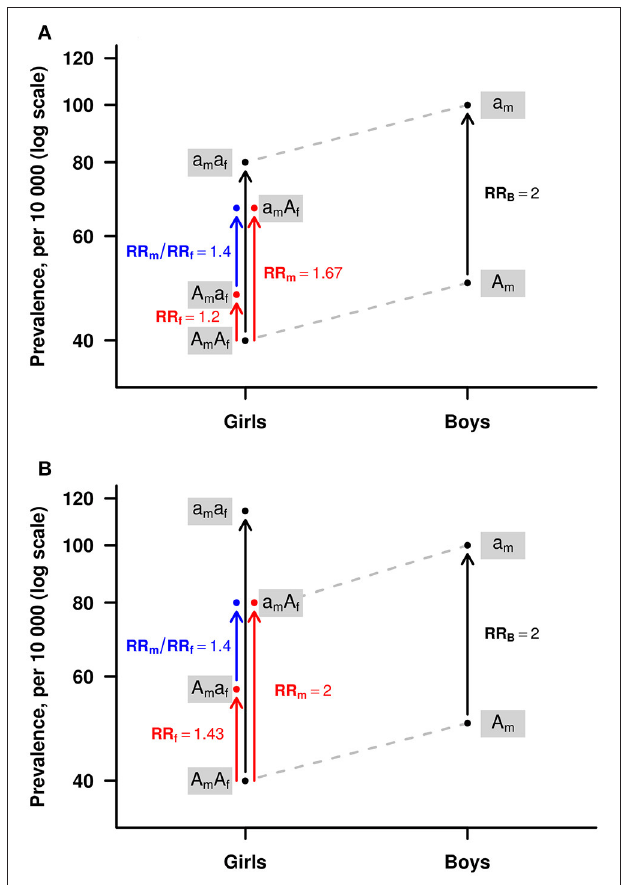
FIGURE 1 | An illustration of the Haplin model for parent-of-origin (PoO) effects on the X chromosome. The red arrows show the relative risks associated with girls inheriting the risk allele “a” from the mother (RR m ) or from the father (RR f ). Under the multiplicative risk model illustrated here, the relative risk increase for “aa” girls, i.e., girls inheriting allele “a” from both the mother and the father, is RRaa = RR m *RR f . The ratio RR m /RR f = 1.4 is a measure of the PoO effect (blue arrow). The risk increase for boys when inheriting the “a” allele is RR B = 2.0. Under the assumption of X-inactivation (A) , the risk increase for girls inheriting “aa” is the same as that for a single “a” in boys, i.e., RRaa = RR B . Under the assumption of no X-inactivation (B) , the risk increase for girls inheriting “a” from the mother is the same as that for boys, i.e., RR m = RR B . In the model without X-inactivation, when a girl inherits “a” from the father as well, this may lead to a higher total risk increase for girls than for boys inheriting the one “a” from the mother. In this illustration, RRaa = RR m *RR f = 2.86 > RR B . The model allows different baseline risks for girls and for boys, here 0.4 and 0.5%,